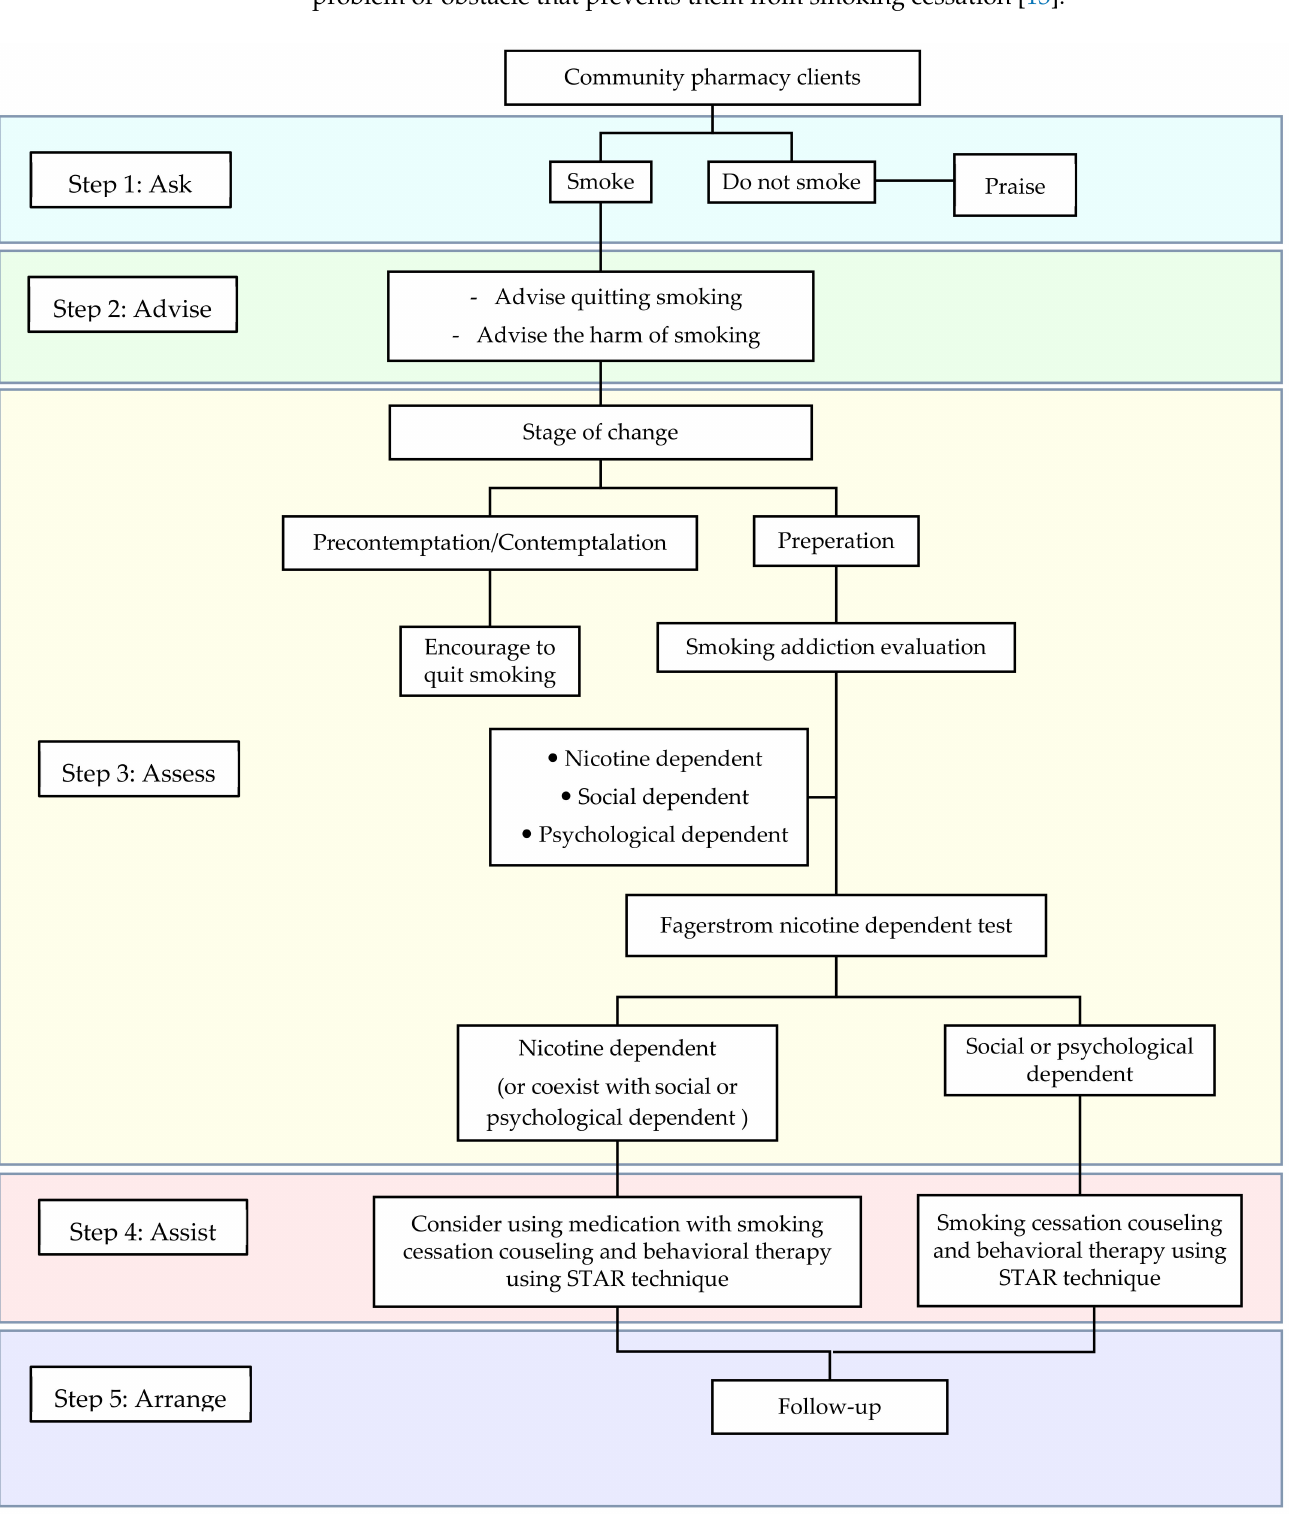
Figure 1. Pharmacist’s role in the community pharmacy smoking cessation service based on the 5A’s